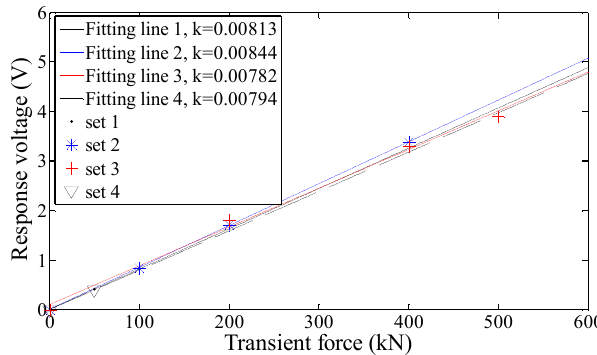
Figure 17. Linear fitting results of the four sets shown in Table 4.